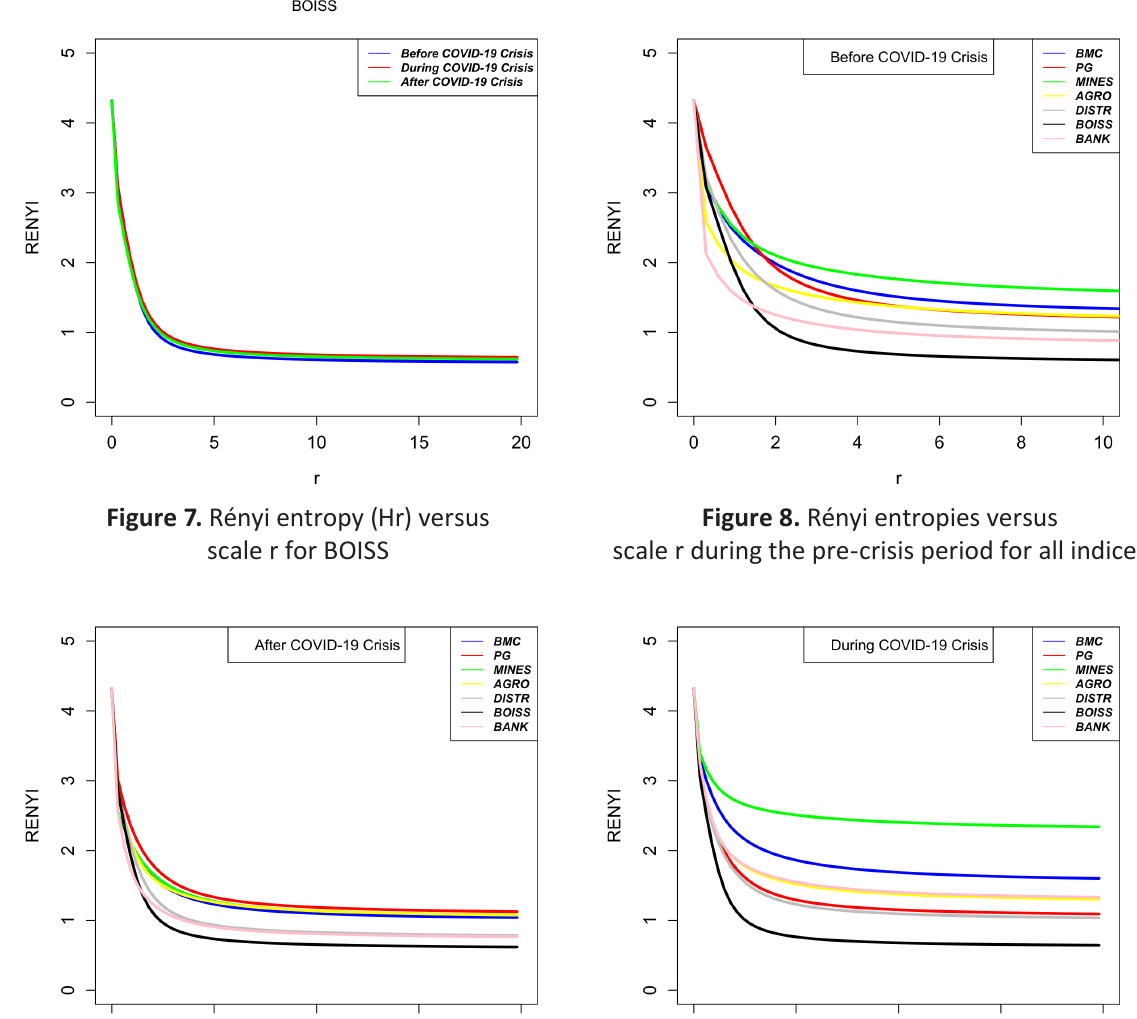
Figure 9. Rényi entropies versus scale r during the post-crisis period for all indices.